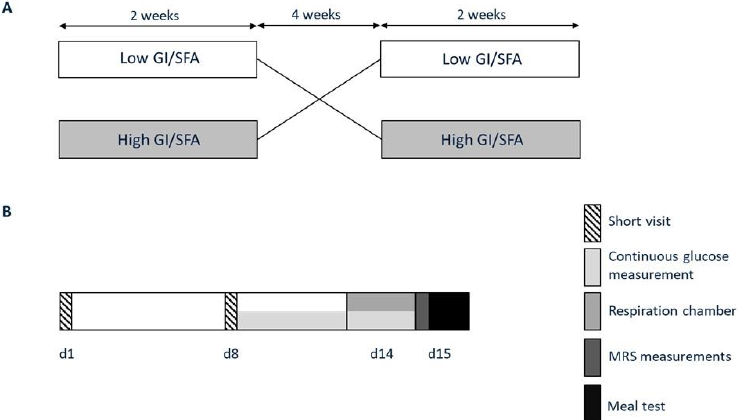
Figure 1. Study protocol. ( A ) Participants participated in two dietary interventions in a randomized order; a two-week high-GI/SFA diet and a two-week low-GI/SFA, interspersed by a four-week washout. ( B ) At the end of each dietary intervention, volunteers visited the university for study measurements (days 14 – 15). At the start and after one week of each of the intervention periods, participants visited the research facilities for instructions and body weight and food intake evaluation (short visits d1 and d8).